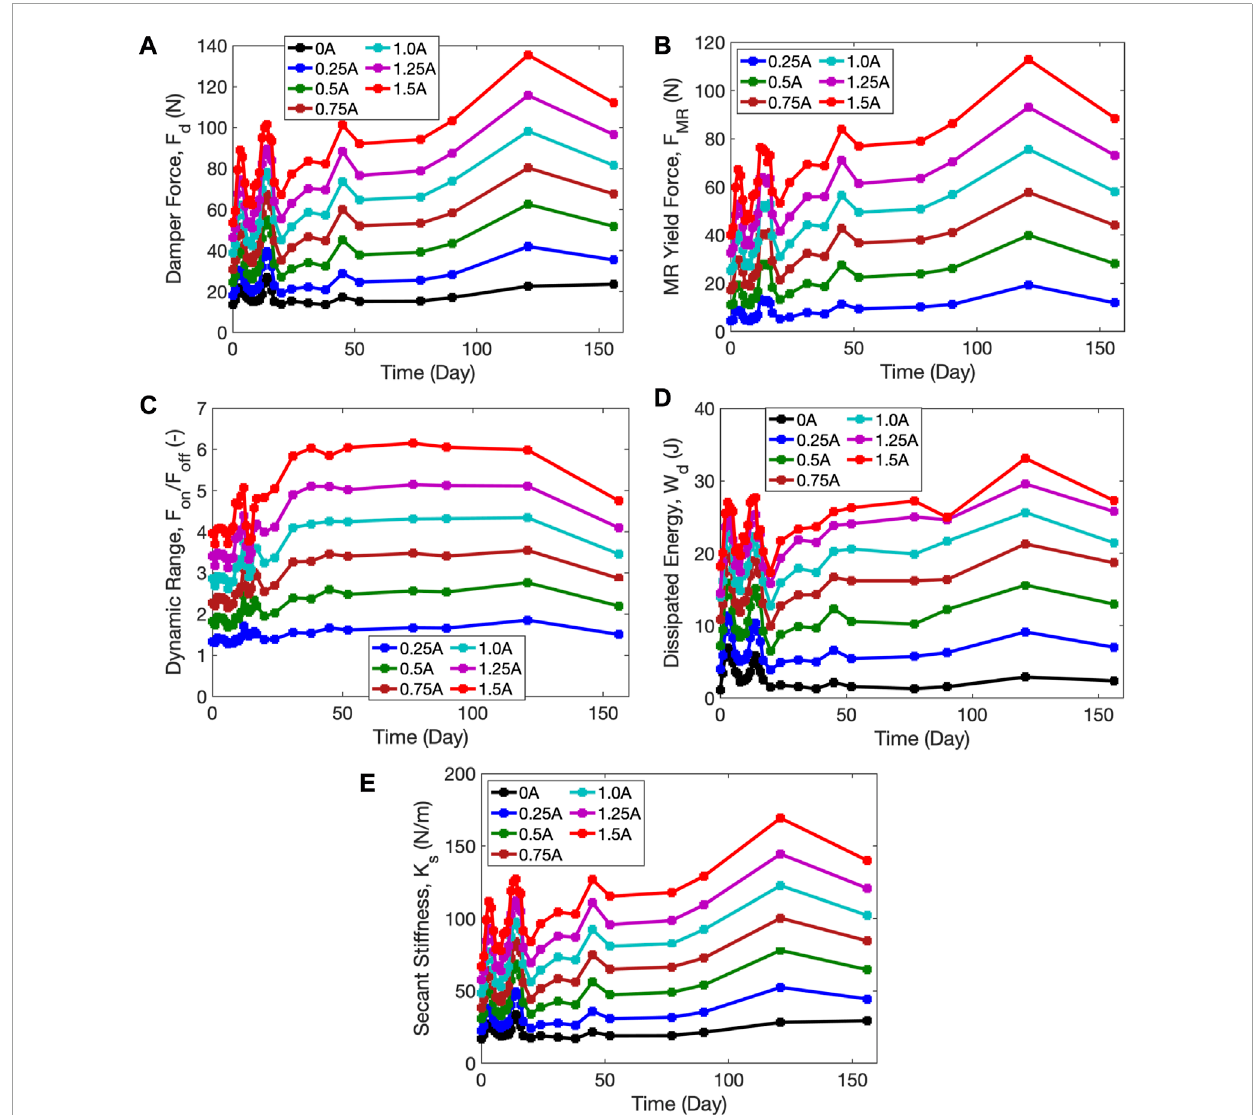
FIGURE 7 Long-term history of the magnetic field-controllable performances of the 3D-printed MRVI. (A) F d . (B) F MR . (C) DR . (D) W d . (E) K s .